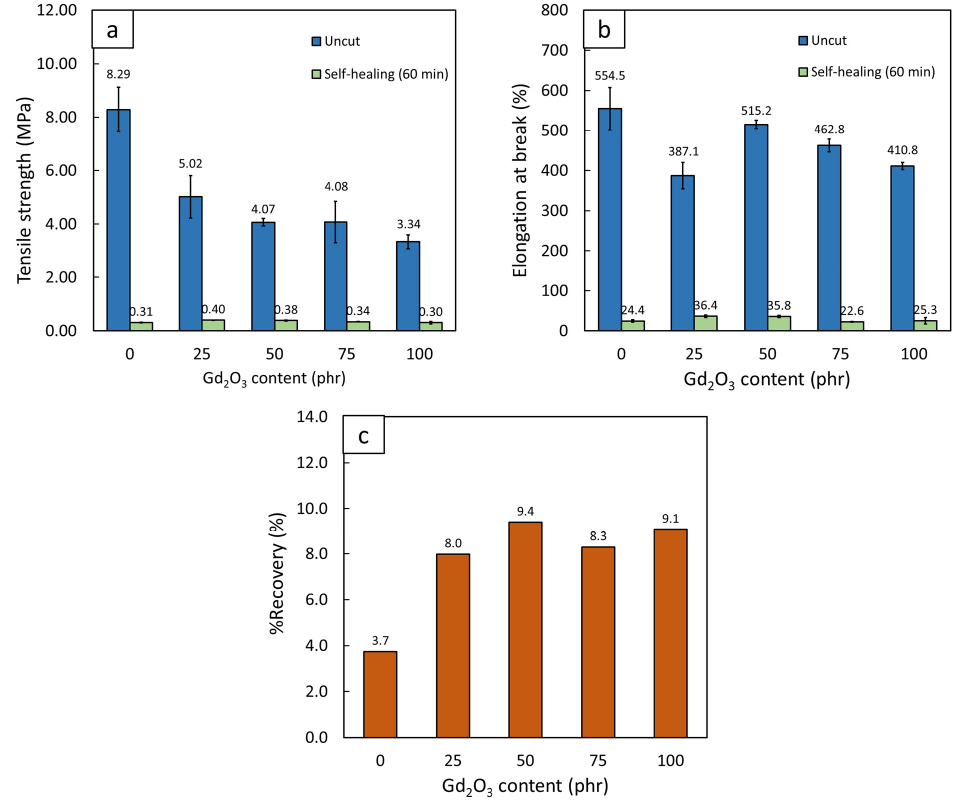
Figure 9. Comparison of ( a ) tensile strength, ( b ) elongation at break, and ( c ) percentage of recovery (%Recovery) for uncut and self-healed Gd 2 O 3 /NR composites containing varying Gd 2 O 3 contents (0, 25, 50, 75, and 100 phr), where error bars indicate ± standard deviation.